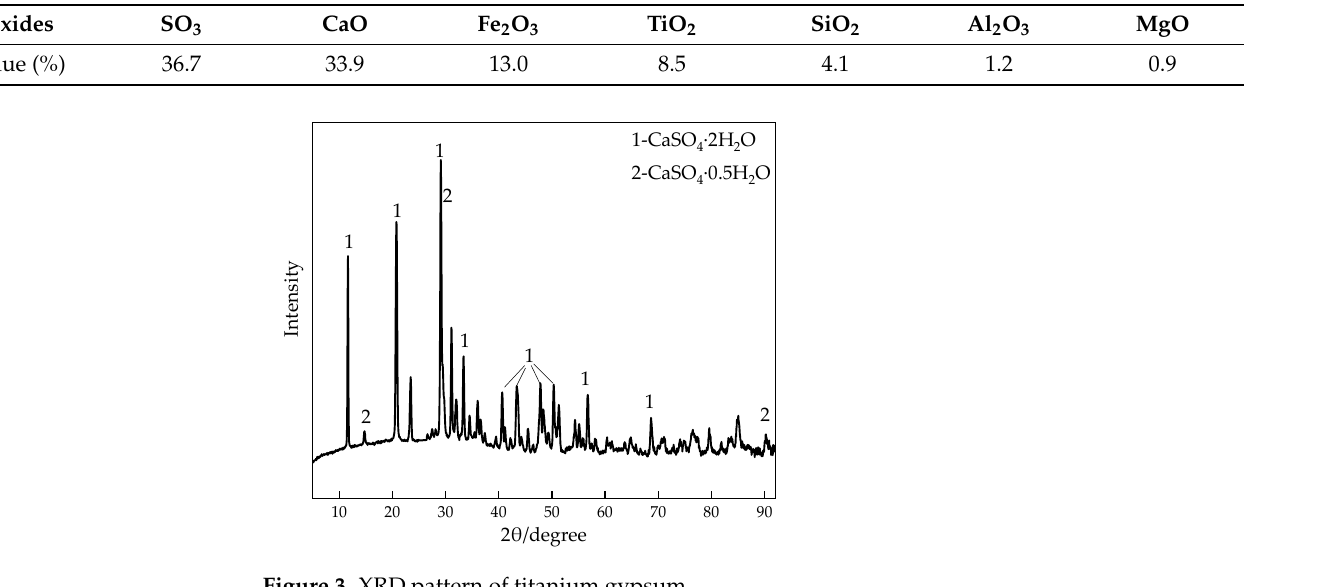
Table 3. Main chemical composition of titanium gypsum.